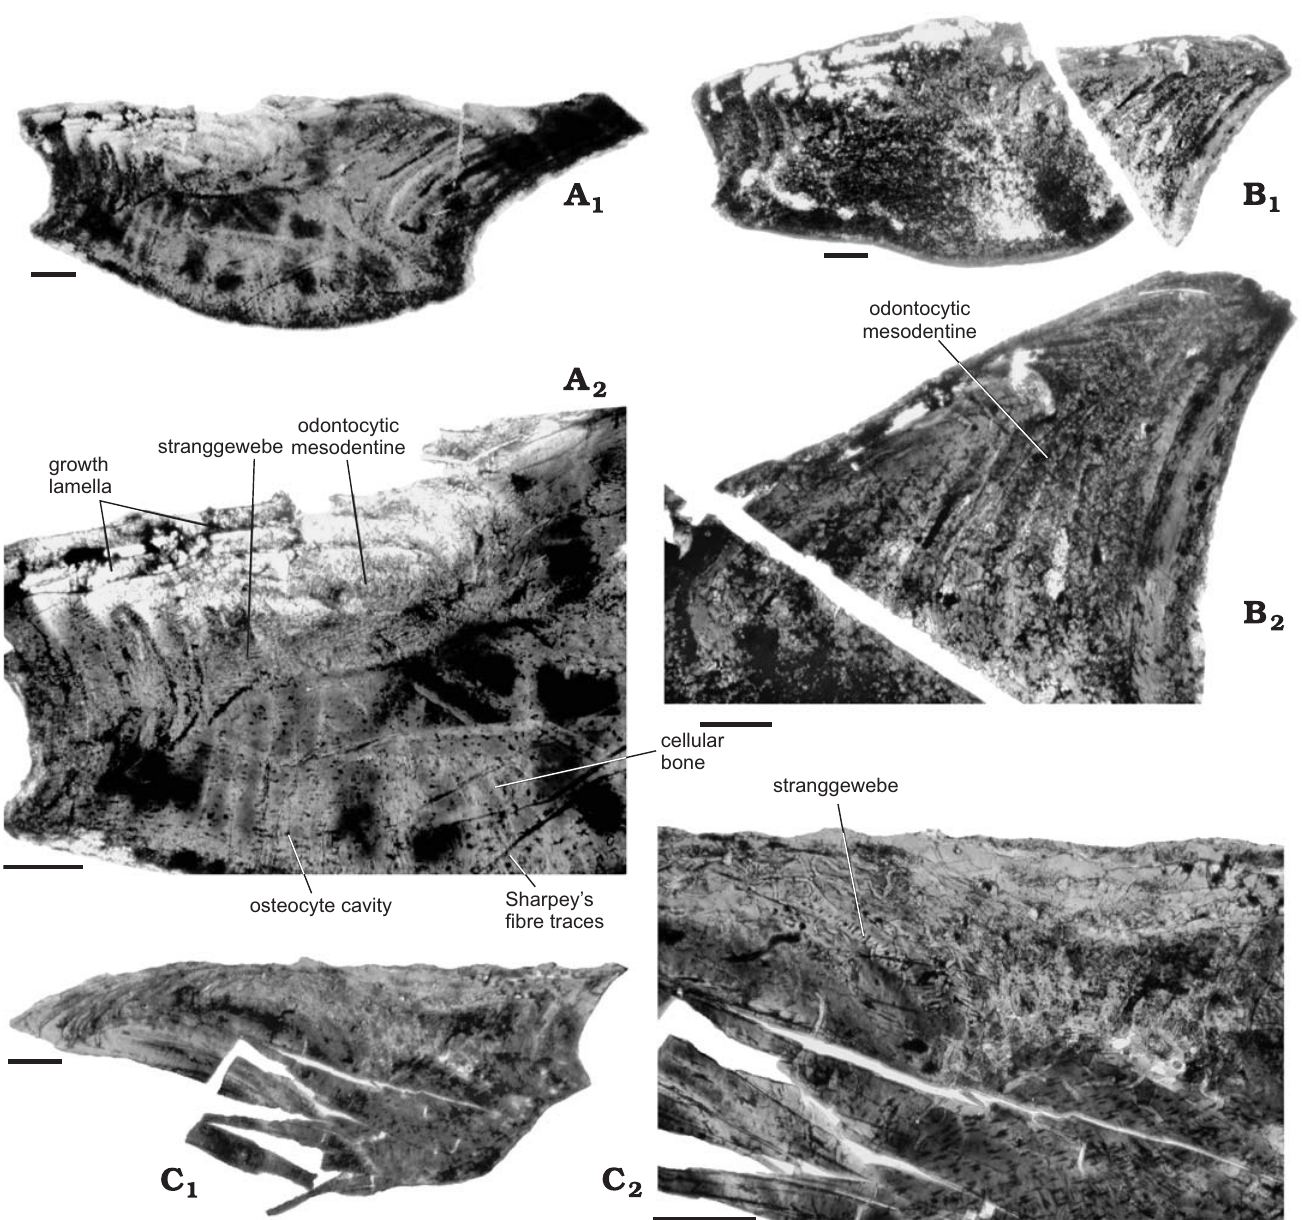
Fig. 7. Climatiid acanthodian Nostolepis sp. cf. N. gaujensis Valiukevičius, 1998 from early Frasnian, horizon GI4 of an unnamed formation in the Chahriseh section, Kaftari Mt., central Iran. Photomicrographs of vertical transverse sections of specialised scales from the lateral sensory line. A . Thin sec− tion LIGG 3816. A 1 , general view of a scale sectioned through the central base part and showing growth characters; A 2 , the anterior, left part of the same scale at higher magnification exposing distribution of densely cellular mesodentine and stranggewebe in growth zones of crown, and structure of adjacent base part showing large numbers of osteocytes and long Sharpey’s fibre bundles. B . Thin section LIGG 3817. B 1 , structure of odontocytic mesodentine in the anterior crown part; B 2 , finely networked mesodentine incorporating densely concentrated osteocytes in growth zones of crown, at high magnification. C . Thin section LIGG 3818 showing general view (C 1 ) and a small portion of the short−lacunal stranggewebe developed in the crown amongst the odontocytic mesodentine (at higher magnification, C 2 ) characteristic of most of the crown. Scale bars 0.1 epis as it has scales with all the characteristic tissues compos− (Fig. 7A ). Bases are comparable to those of flank scales, 2 with thinly lamellar cellular bone. ing crown and base which are diagnostic for the genus, in both articulated specimens and isolated microremains. The new material includes more morphological varieties of flank scales than previously recognised, and also specialised asymmetrical scales of a “ Pruemolepis ”−type having similar (2002: fig. 9A–H), from the same geological horizon of the Chahriseh section. The taxon belongs to the genus Nostol− tissue microstructure.